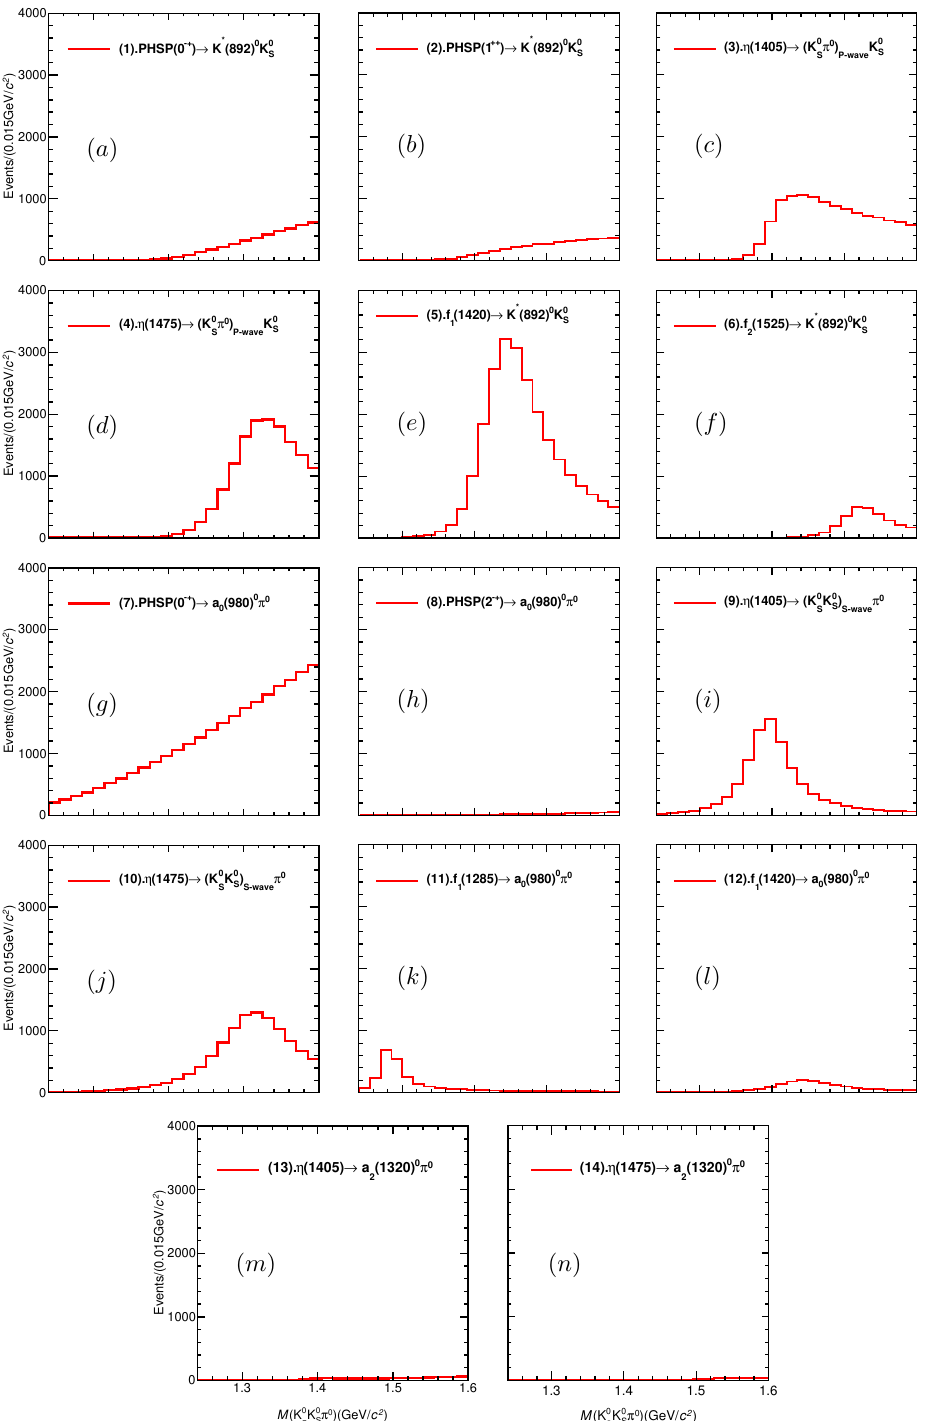
Figure 5 . Invariant mass distribution of K 0 sponding to table 3 included in the MD PWA nominal